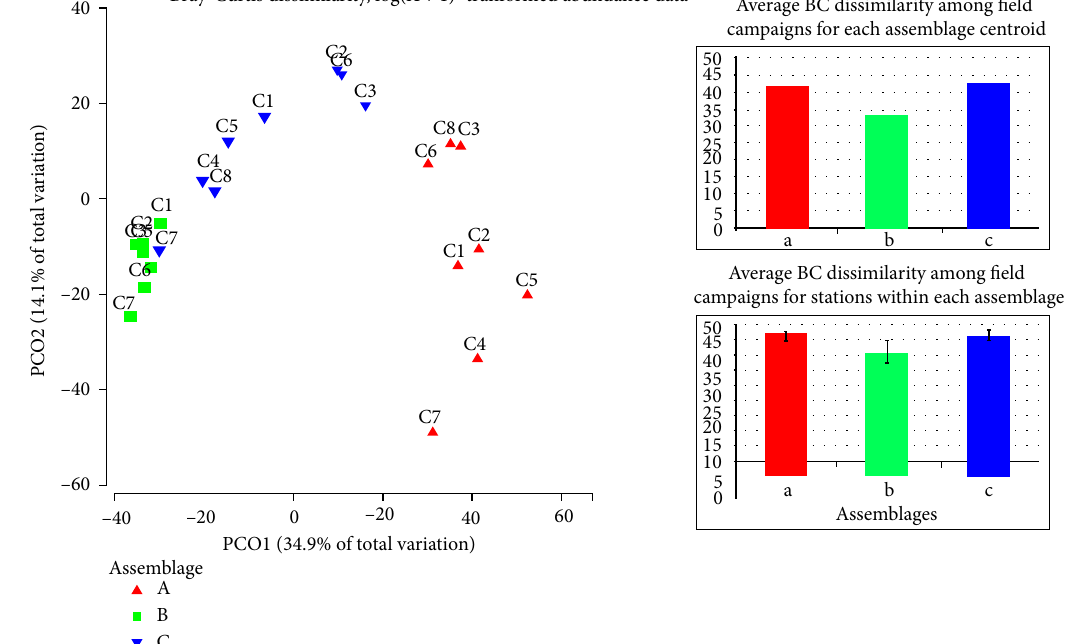
Figure 8: PCO plot of assemblage centroids at each time point from August 2014 (“C1”) to June 2016 (“C8”). Labels indicate the time points of sampling (according to Table S1 in the Supplementary